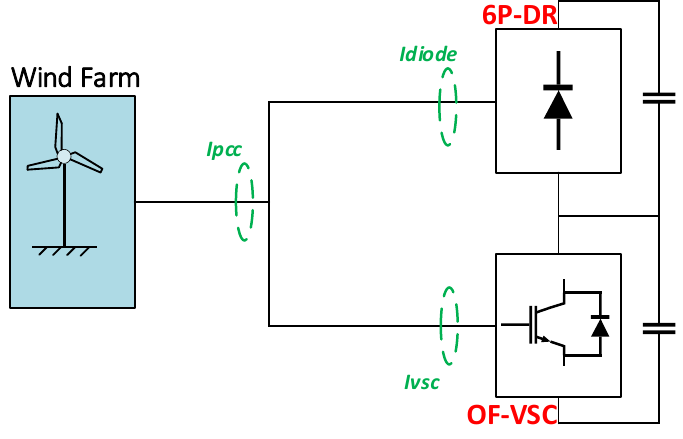
Figure 4. The harmonics mitigation in the hybrid converter.